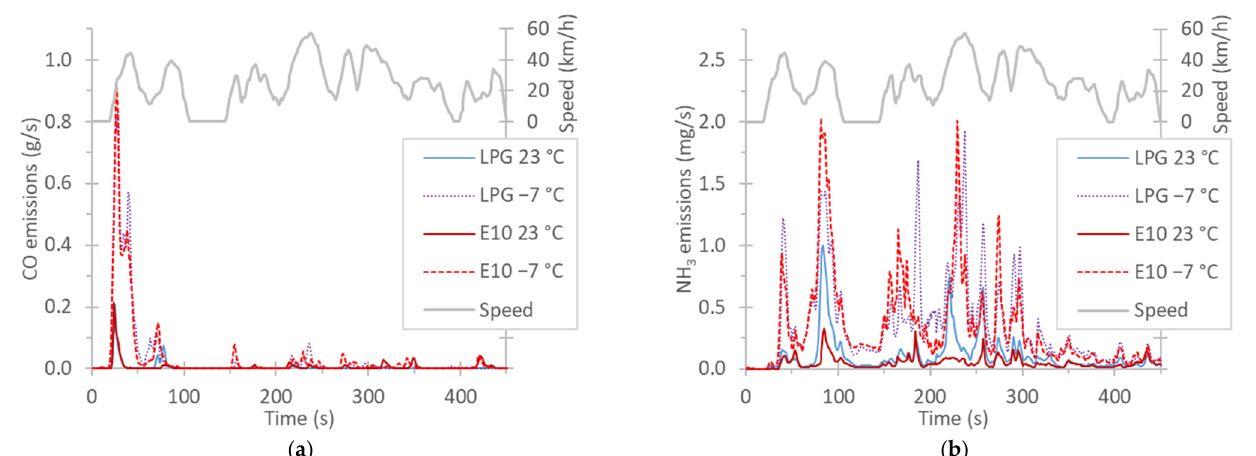
Figure 5. Real-time emissions of vehicle Bi-LPG #2 over the first 450 s of a cold start WLTC at 23 °C and − 7 °C: ( a ) CO; ( b ) NH 3 . The speed profile is given as a thin grey line.